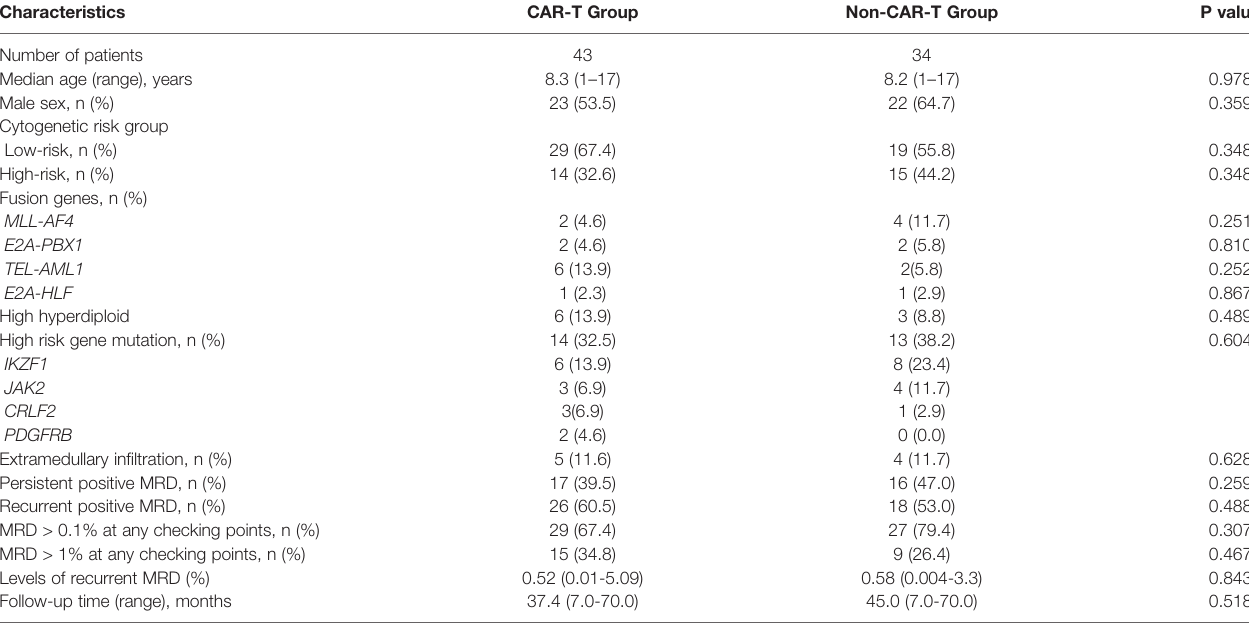
TABLE 1 | Characteristics of patients strati fi ed by CAR-T and non-CAR-T group. Characteristics